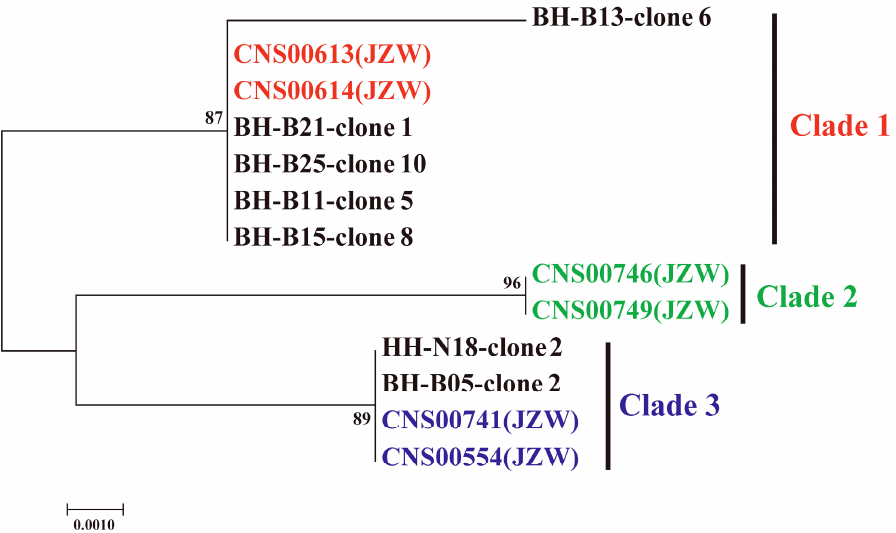
Figure 8. Phylogenetic analysis based on the cgmt1 sequences of C. granii obtained from strains and environmental samples. The sea areas were marked with abbreviations: Jiaozhou Bay (JZW), Bohai Sea (BH), and Yellow Sea (HH).